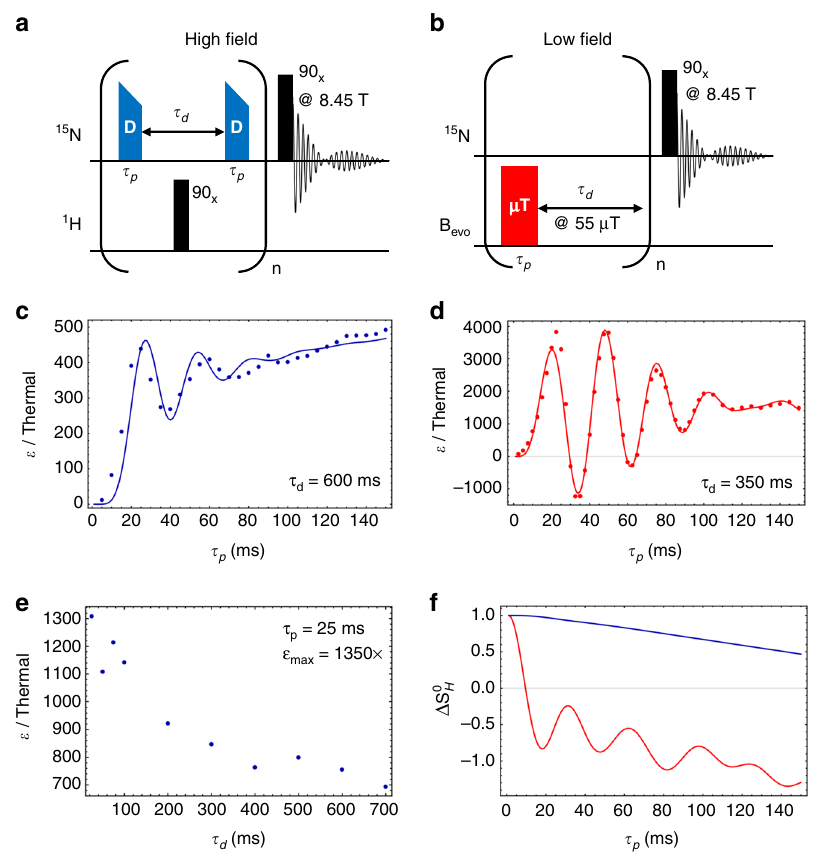
Fig. 2 Coherent hyperpolarization experiments. a DARTH_SABRE pulse sequence, where DARTH-pulses of length τ p are given at intervals of τ d for “ n ” repetitions and applied to the bound 15 N spin slightly off-resonance. The pulses adiabatically ramp towards the optimal matching condition to induce higher polarizations. b Coherent SHEATH pulse sequence, where analogous pulses are delivered to the sample at the optimal fi eld condition, which is typically ≈ 0.5 μ T, with inter-pulse delays using a ≈ 55 μ T fi eld to store magnetization. c Experimental DARTH-SABRE dynamics of an AA ’ XX ’ spin system using 50 mM 15 N-pyridine with an inter-pulse delay of τ d = 600 μ s at 8.45 T. d Experimental coherent SHEATH dynamics of an AA ’ X spin system using 100 mM 15 N-benzonitrile with 33 mM pyridine and an inter-pulse delay of τ d = 350 ms; detection was performed at 8.45 T. Data are shown fi t to numerical QMC simulations using average PTC lifetimes of 20 ms (DARTH) and 50 ms (SHEATH). e Polarization as a function of the delay parameter for the DARTH-SABRE sequence using a 25 ms DARTH pulse, which corresponds to a π pulse. f Evolution of singlet population excess (DARTH AA ’ XX ’ : S H 0 – T H 0 , blue line; SHEATH AA ’ X: S H 0 – T H - , red line) under the conditions used in the fi t of the experimental data and normalized to the initial S H 0